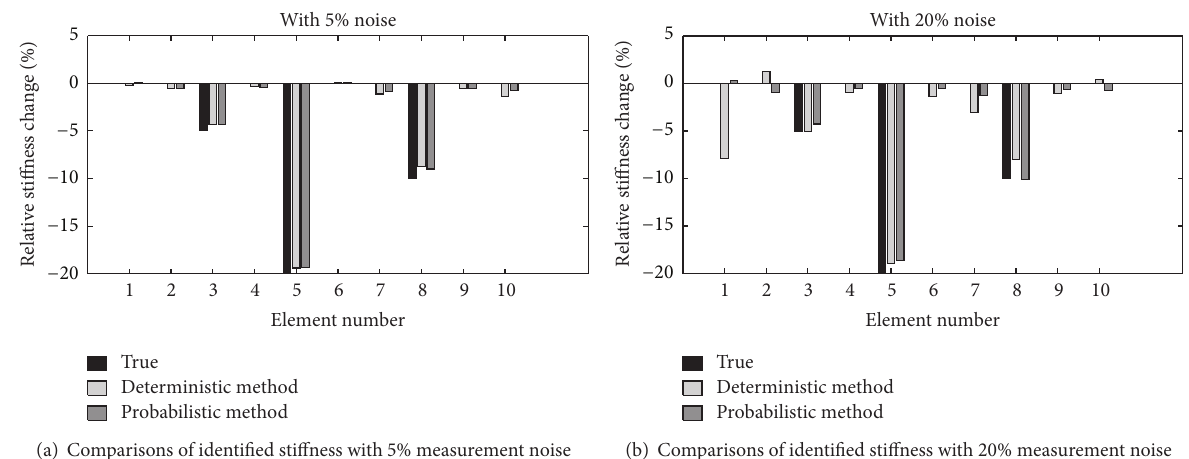
Figure 1: Comparisons of identification stiffness with different measurement noise levels.